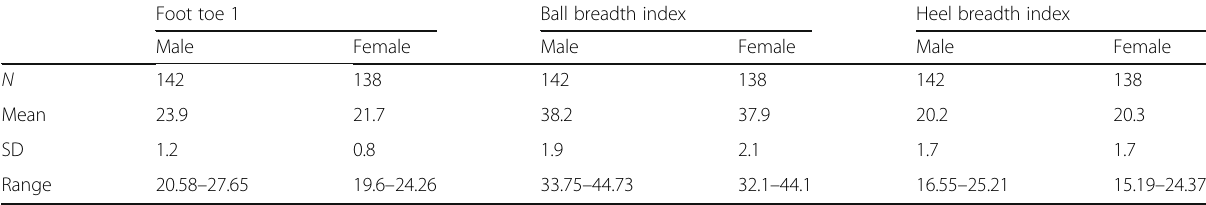
Table 3 Descriptive statistics: right foot dimensions and foot index among Punjabi population